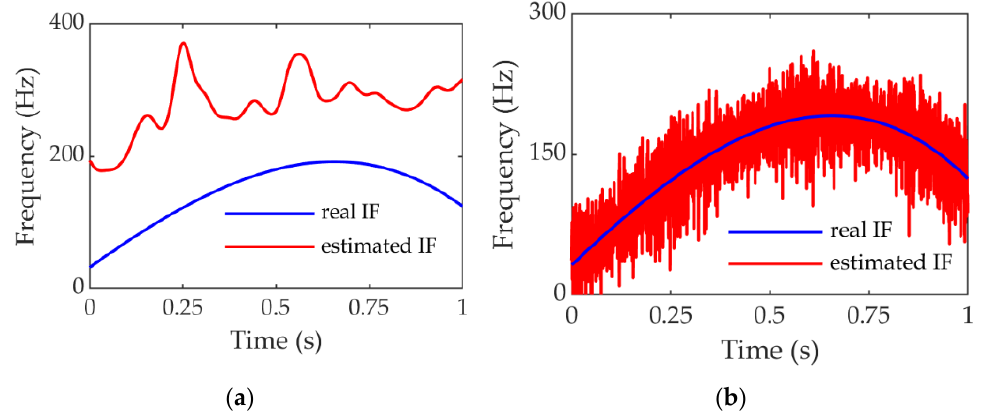
Figure 5. ( a ) The IF estimated by the first conditional spectral moment of the time-frequency distribution of the signal under SNR = 0 dB; ( b ) the IF estimated by the derivative of the phase of the analytic form of the signal obtained by the Hilbert transform under SNR = 20 dB.